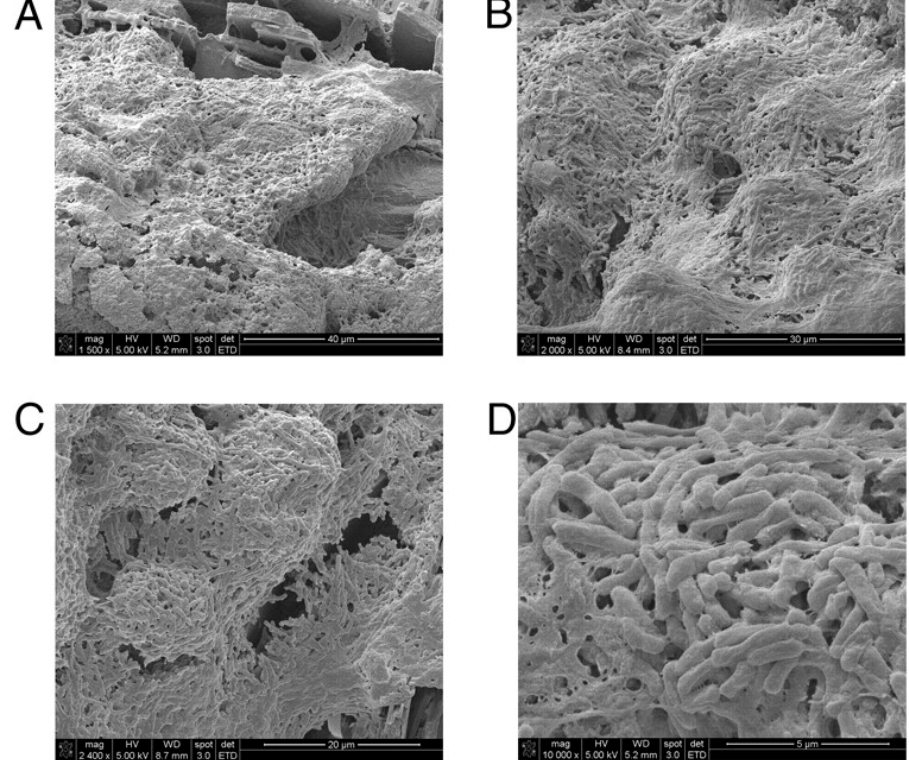
Figure 1. Gallbladder stones from an asymptomatic typhoid carrier in Mexico City support biofilm formation. SEM micrographs show S . Typhi embedded in biofilms on the surfaces of gallstones at magnifications of 1500× ( A ), 2000× ( B ), 2400× ( C ), and 16,000× ( D ). R.W. Crawford et al. [73].